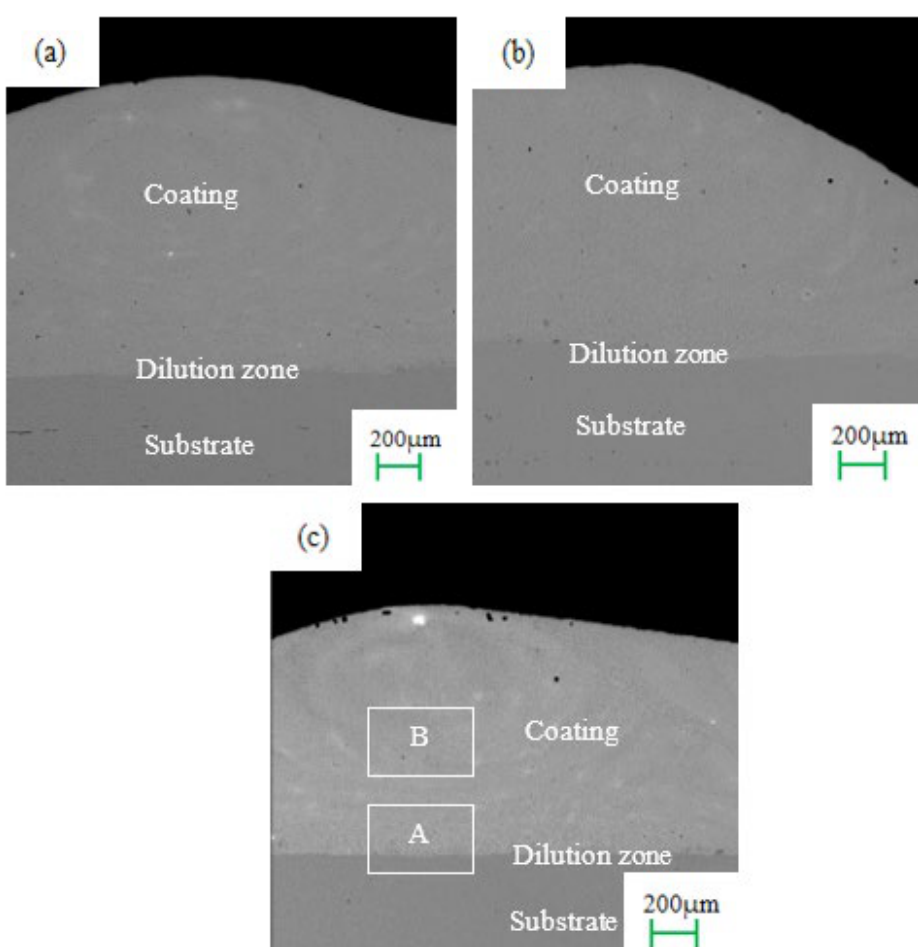
Figure 4. The macrograph of ( a ) CoCrNi, ( b ) CoCrNiMo 3 , and ( c ) CoCrNiMo 5 coating.